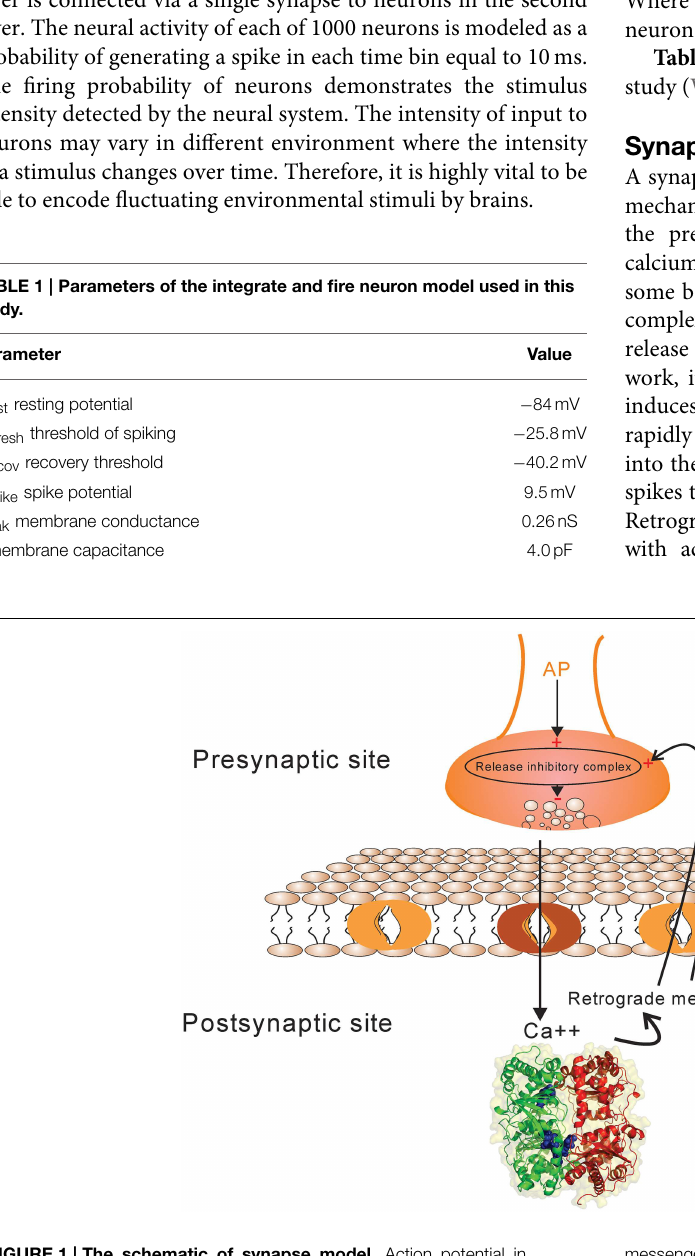
Frontiers in Cellular Neuroscience |